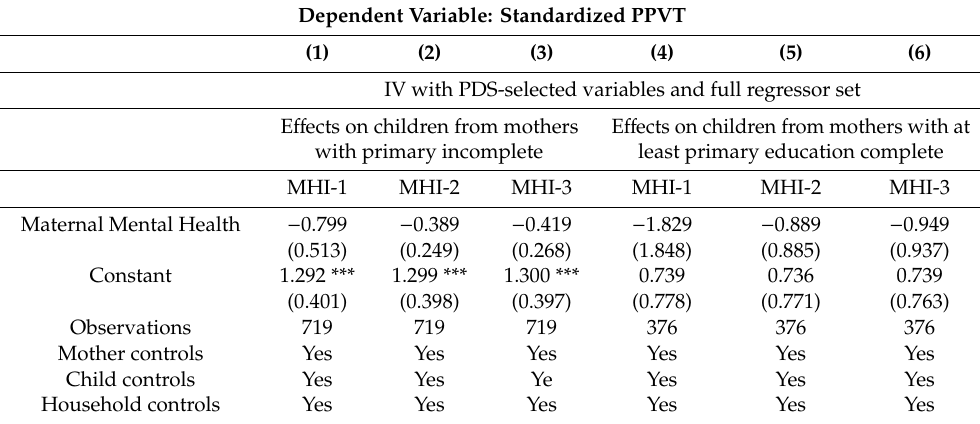
Table 6. Heterogeneous e ff ects of maternal mental health on children’s vocabulary at age 5 by the educational level of the